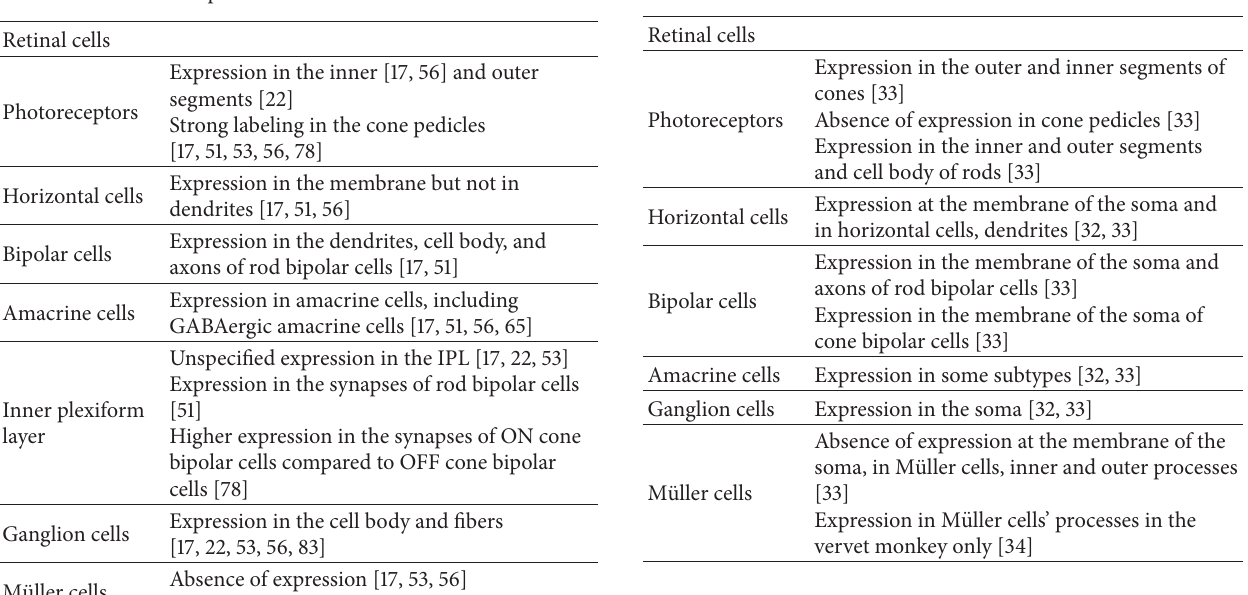
Table 3: Cannabinoid receptor type 2 protein distribution in the adult